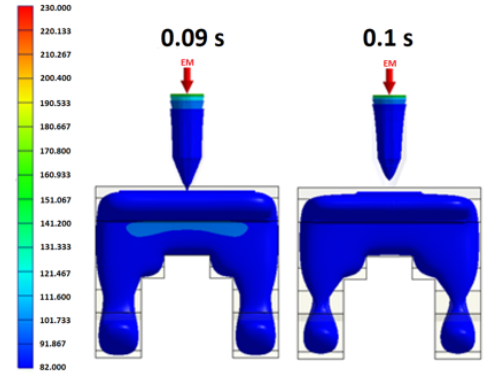
Figure 8. Temperature distribution in gate area of mold after packing times of 0.09 s (left) and 0.1 s (right).